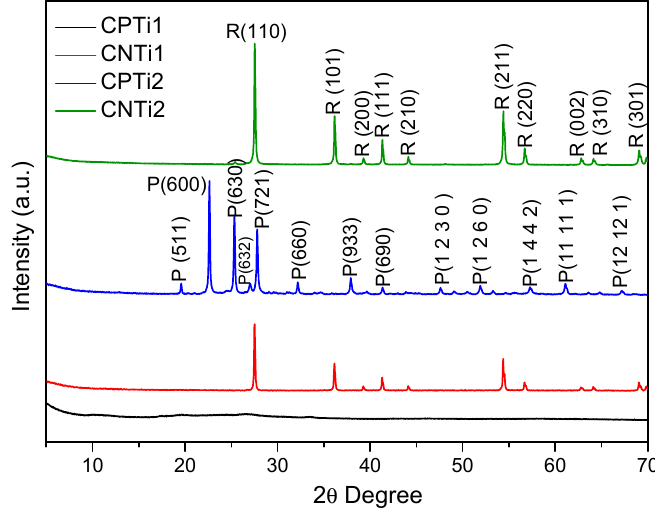
Figure 3. X-ray di ff raction (XRD) patterns of the carbon–Ti composites (R = rutile, P = TiP 2 O 7 Figure 3. X-ray diffraction (XRD) patterns of the carbon–Ti composites (R = rutile, P = TiP 2 O 7 ).